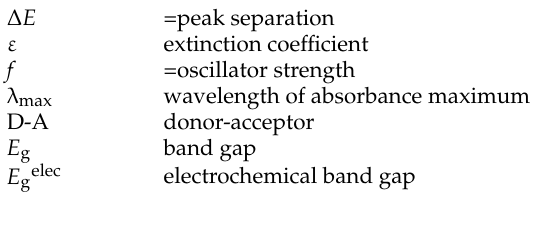
Figure S1: 1 H NMR Spectrum of Compound 10 ; Figure S2: 13 C NMR Spectrum of Compound 10 , Modeling of 2nd order coupling effects in Compound 10 ; Figure S3: Comparison of results from modeling of 2nd order coupling effects in the 1 H NMR spectrum of 10 ; Figure S4: 1 H NMR Spectrum of Compound T3 ; Figure S5: 1 H NMR Spectrum of Compound T4 ; Figure S6: 1 H NMR Spectrum of Compound T5